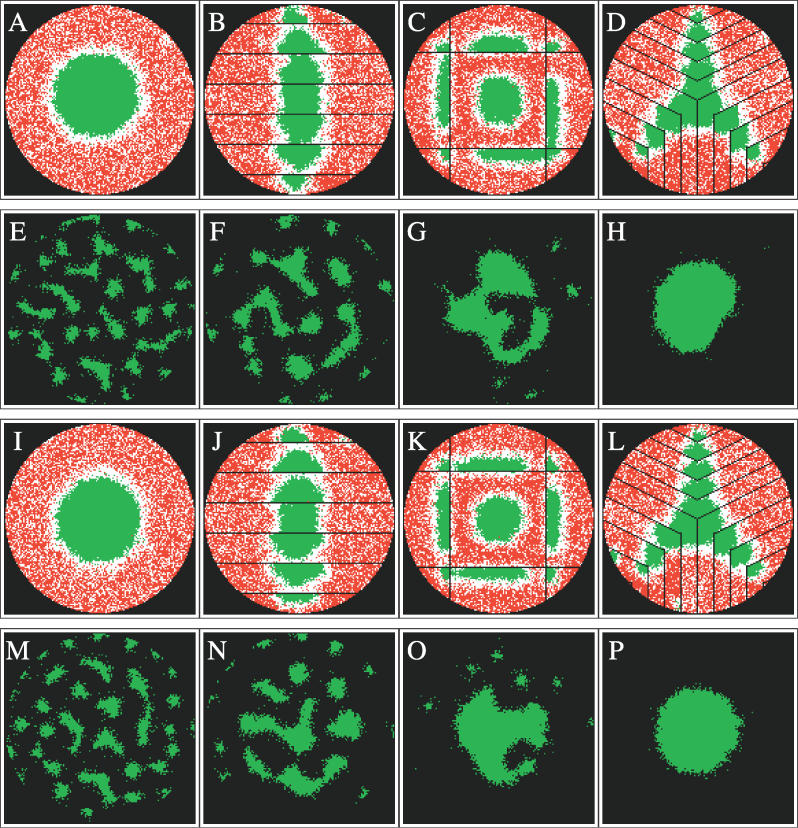
IS Pattern Formation Composed of TCR–pMHC Complexes (Green) and LFA-1–ICAM-1 Complexes (Red) for Two Different Types of Interactions That Both Reproduce the Experimentally Observed ISs (in Mossman et al.) That Were Geometrically Repatterned by Chromium Barriers (Black)Both simulations take adhesion between TCR–pMHC complexes (α = 1), diffusion of TCR–pMHC and LFA-1–ICAM-1 (D = 0.06 μm2/s, and short-range repulsion between TCR–pMHC and LFA-1–ICAM-1 (Lrep = 0.1R, wrep = −1) into account.(A–H) TCR–pMHC aggregation due to long-range attraction (Latt = R, watt = 0.14, wdir = 0).(I–P) TCR–pMHC aggregation due to centrally directed motion (Ldir = R, wdir = 3, watt = 0). The IS formation is shown after 30 s in (E) and (M), after 2 min in (F) and (N), after 5 min in (G) and (O), and after 10 min in (H) and (P).